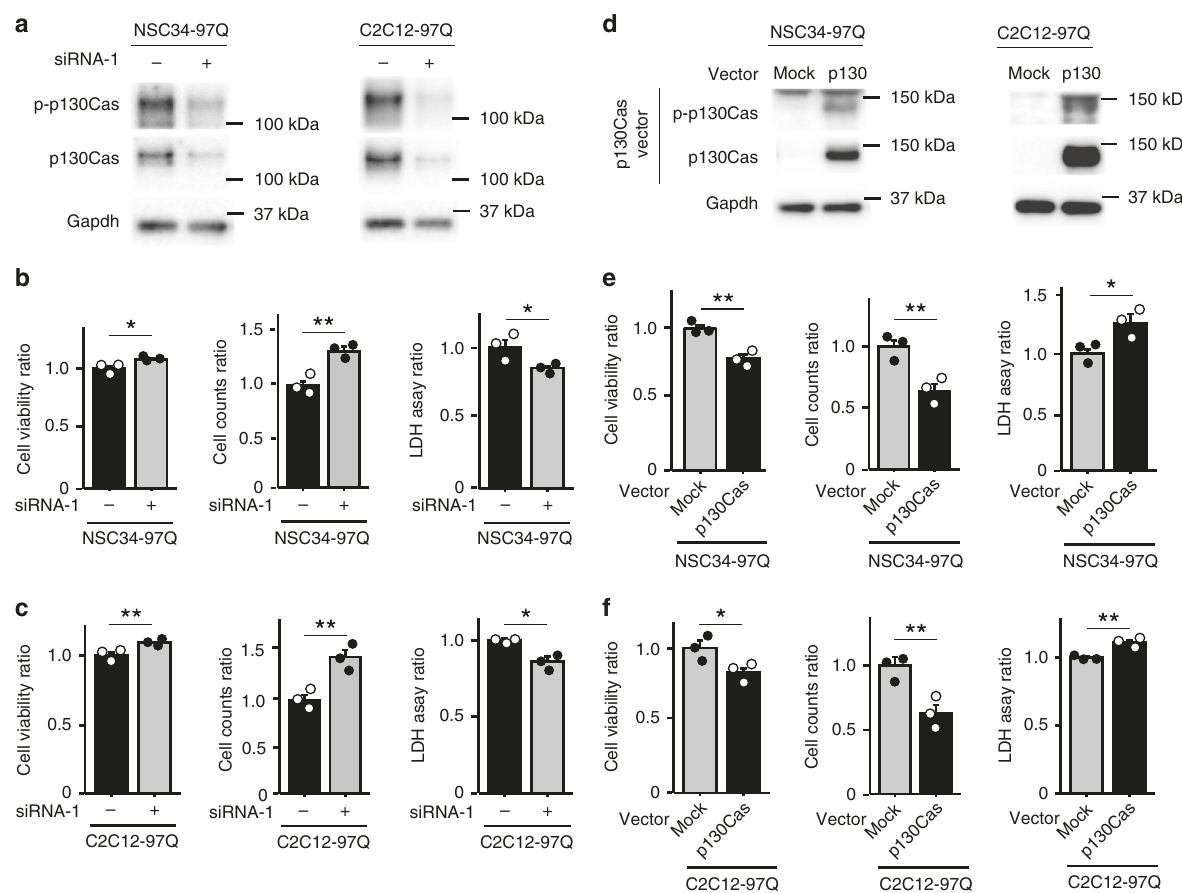
Fig. 8 Phosphorylation of p130Cas exerts toxic effects on cellular models of SBMA. a Immunoblots showing the levels of the p-p130Cas and p130Cas proteins in DHT-treated NSC34 and C2C12 cells stably expressing AR-97Q and transfected with the mock or p130Cas siRNA-1. b , c The viability, cell numbers and LDH release from NSC34 ( b ) and C2C12 cells ( c ) are shown ( n = 3). d Immunoblots showing the levels of phosphorylated and total p130Cas proteins in DHT-treated NSC34 and C2C12 cells stably expressing AR-97Q and transfected with the mock or p130Cas vector. e , f Viability, cell numbers and LDH release from NSC34 ( e ) and C2C12 ( f ) cells are shown ( n = 3). Error bars indicate the s.e.m. Statistical analyses were performed using the unpaired two-sided t -test ( b , c , e , f ). * p < 0.05 and ** p < 0.01. Source data are provided as a Source Data fi le ( a – f (Supplementary Fig. 19d). The SH3 domain of Src binds to 372 – 385 amino acid residues in human AR 29 , which correspond to the DNA sequence of 1345 – 1386 in the AR-97Q vector. We conducted site-speci fi c mutagenesis and created the AR construct with a deletion of 1345 – 1386 (deleted AR-97Q vector), and co-